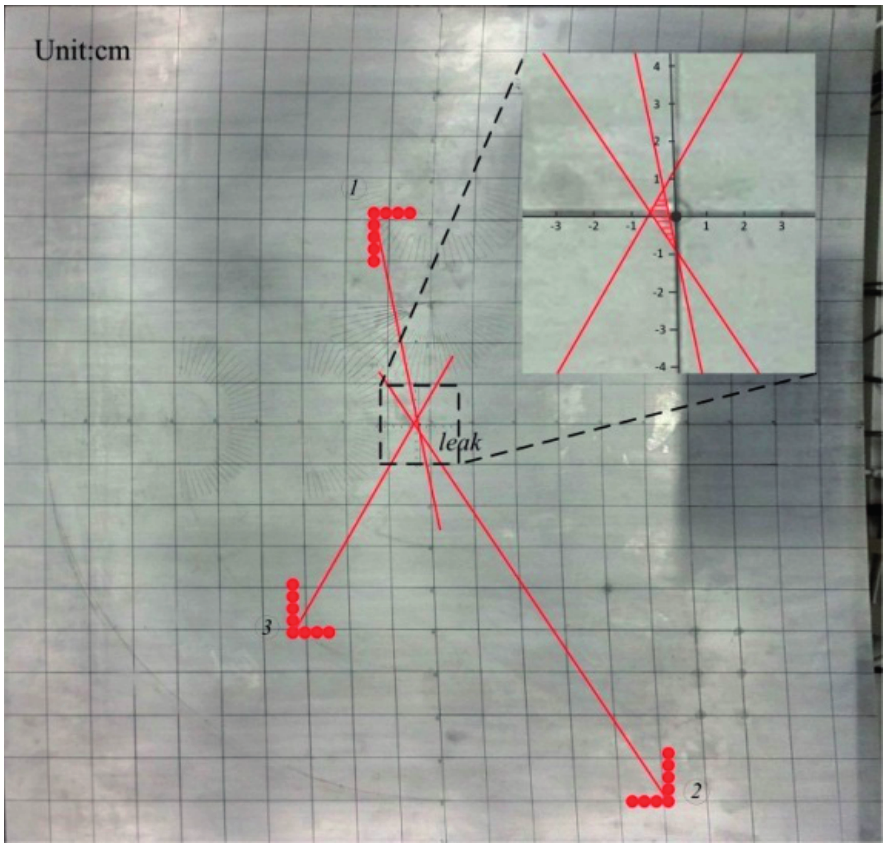
Figure 13. The estimated location